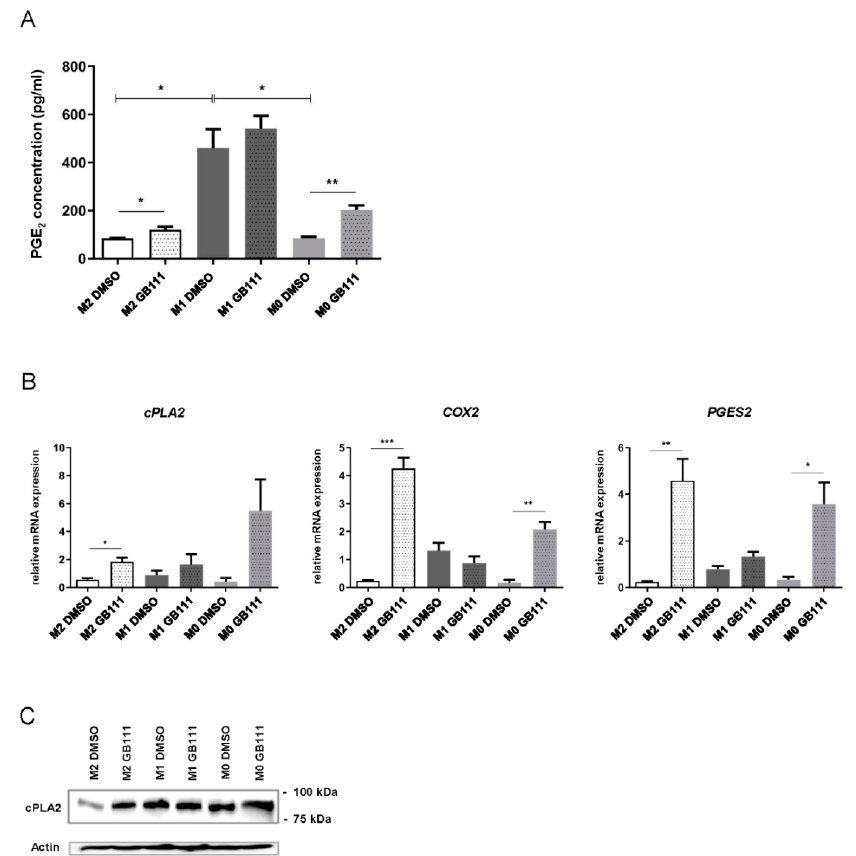
Figure 5. ( A ) Detection of prostaglandin E 2 (PGE 2 ) in the medium supernatant of human M0, M1, and M2 macrophages after inhibitor treatment using an enzyme-linked immunosorbent assay (ELISA). ( B ) Expression of mRNA levels of the PGE 2 synthesis enzymes cPLA2 , COX-2, and PGES2 by real- time PCR in M0, M1, and M2 macrophages treated with GB111-NH 2 or DMSO. Data are presented as mean ± standard deviations (SD) and p -values below 0.05 were considered to be statistically significant (* p ≤ 0.05; ** p ≤ 0.01; *** p ≤ 0.001). ( C ) Representative immunoblot showing cytosolic